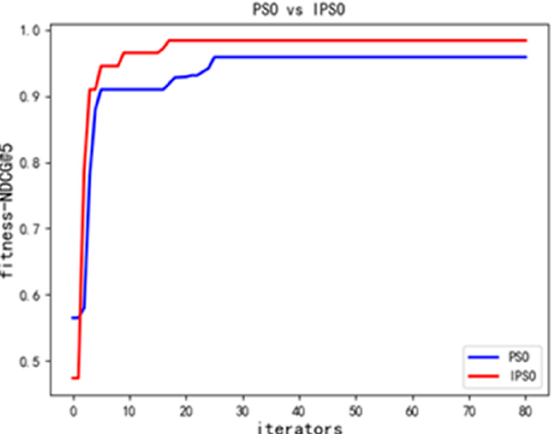
Figure 8. Comparison of experimental results between PSO algorithm and IPSO algorithm.